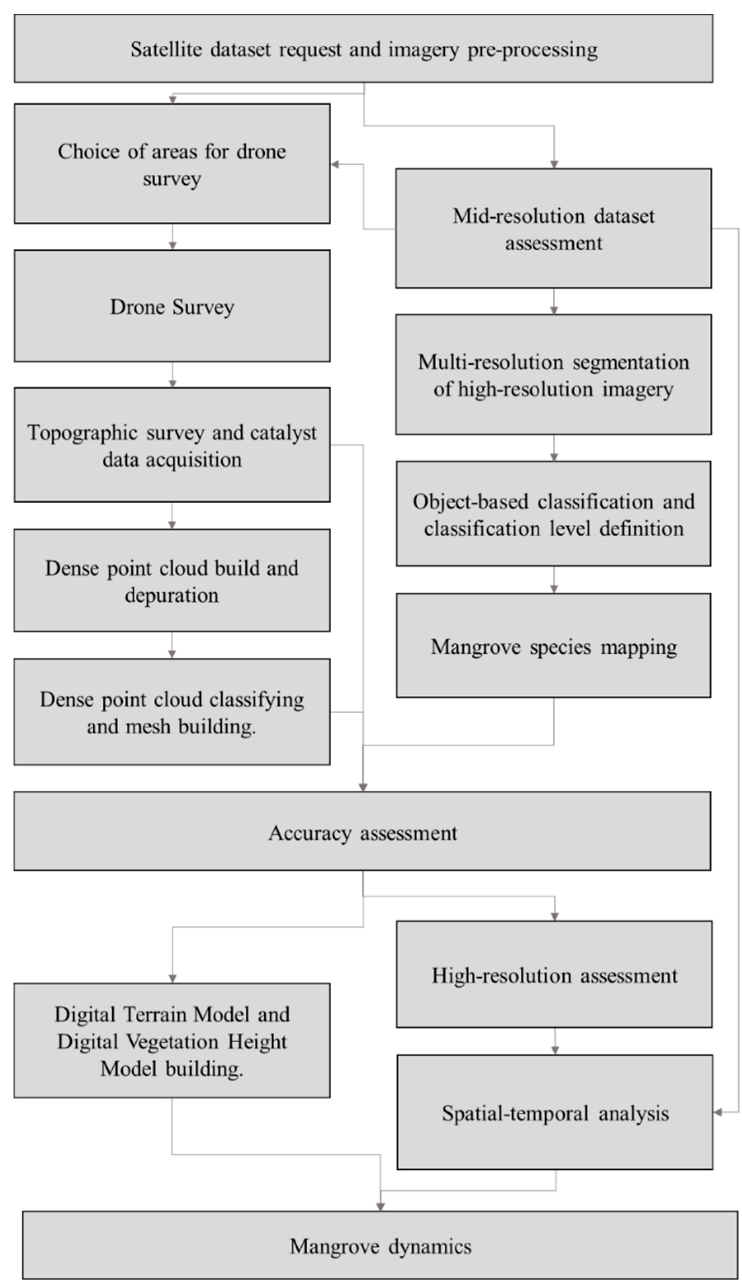
Figure 2. Methodology flowchart.